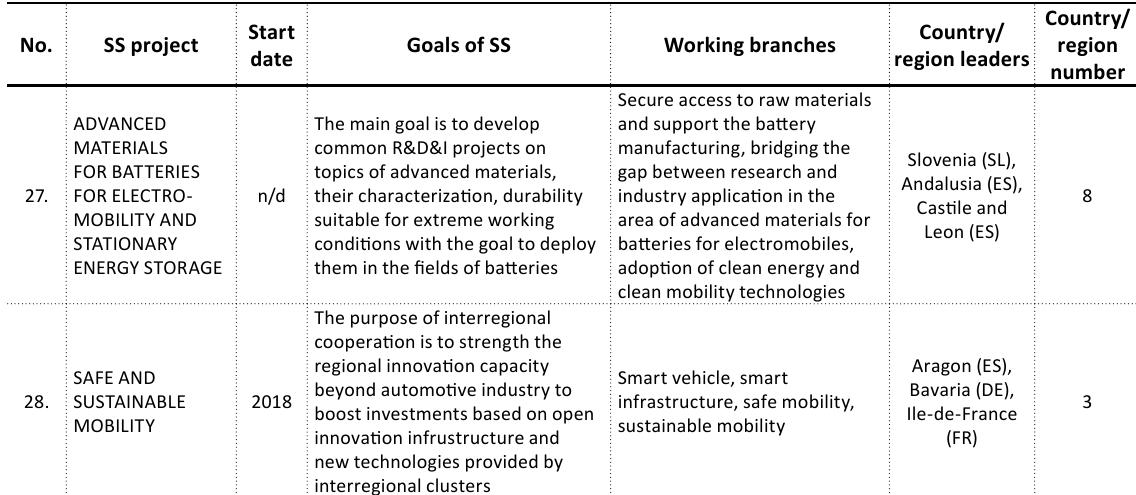
Table A1 (cont.). Examples of SS projects in the EU